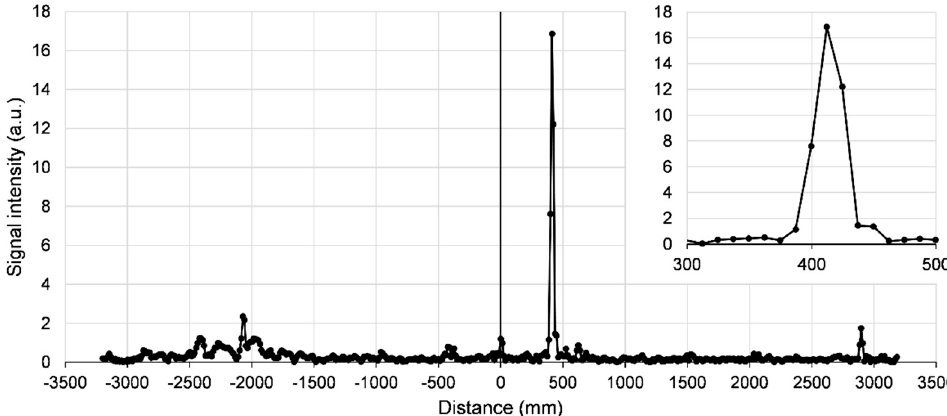
Figure 3. The inverse Fourier transform of the signals in Figure 2. The horizontal axis is converted into distance; the vertical axis is the absolute value of the complex number produced by the Fourier transform. The inset is an expansion around the main peak and shows that the distance information is mainly contained in just three data points.